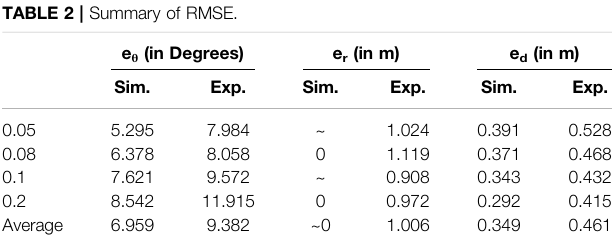
TABLE 2 | Summary of